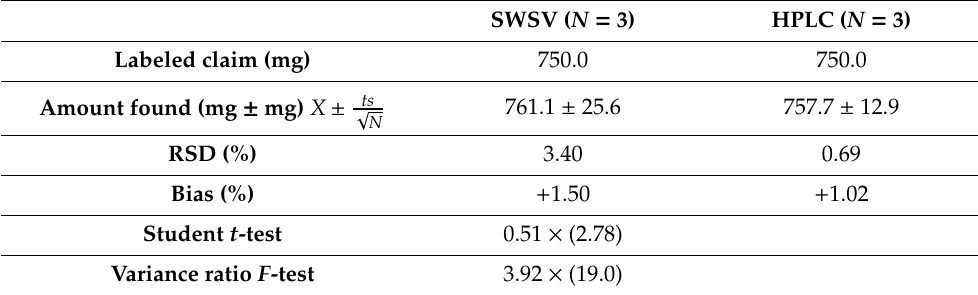
Table 3. Results obtained for oxyclozanide in pharmaceutical formulations Okzan ® by using SWSV and